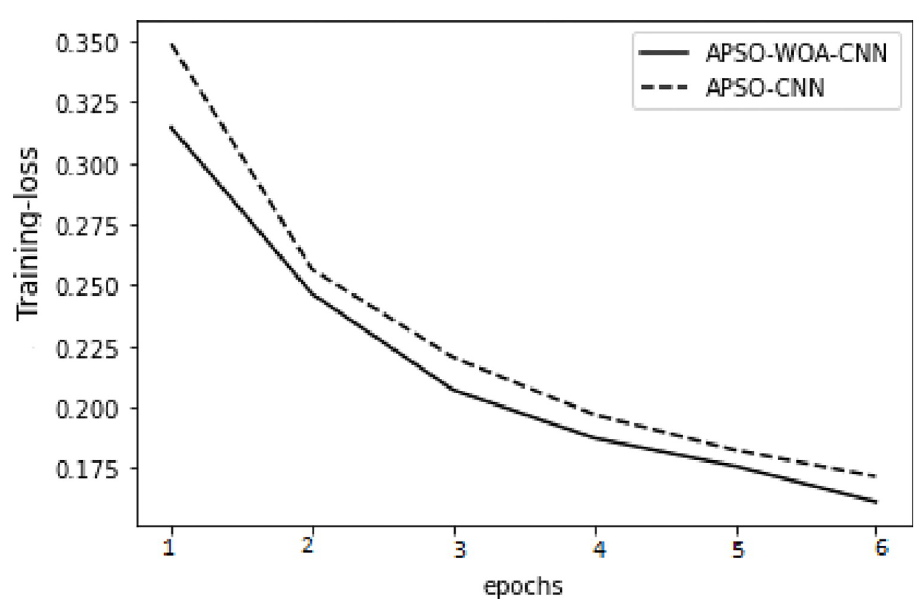
Fig 14. APSO–WOA–CNN and APSO–CNN algorithms’ loss function training sets.